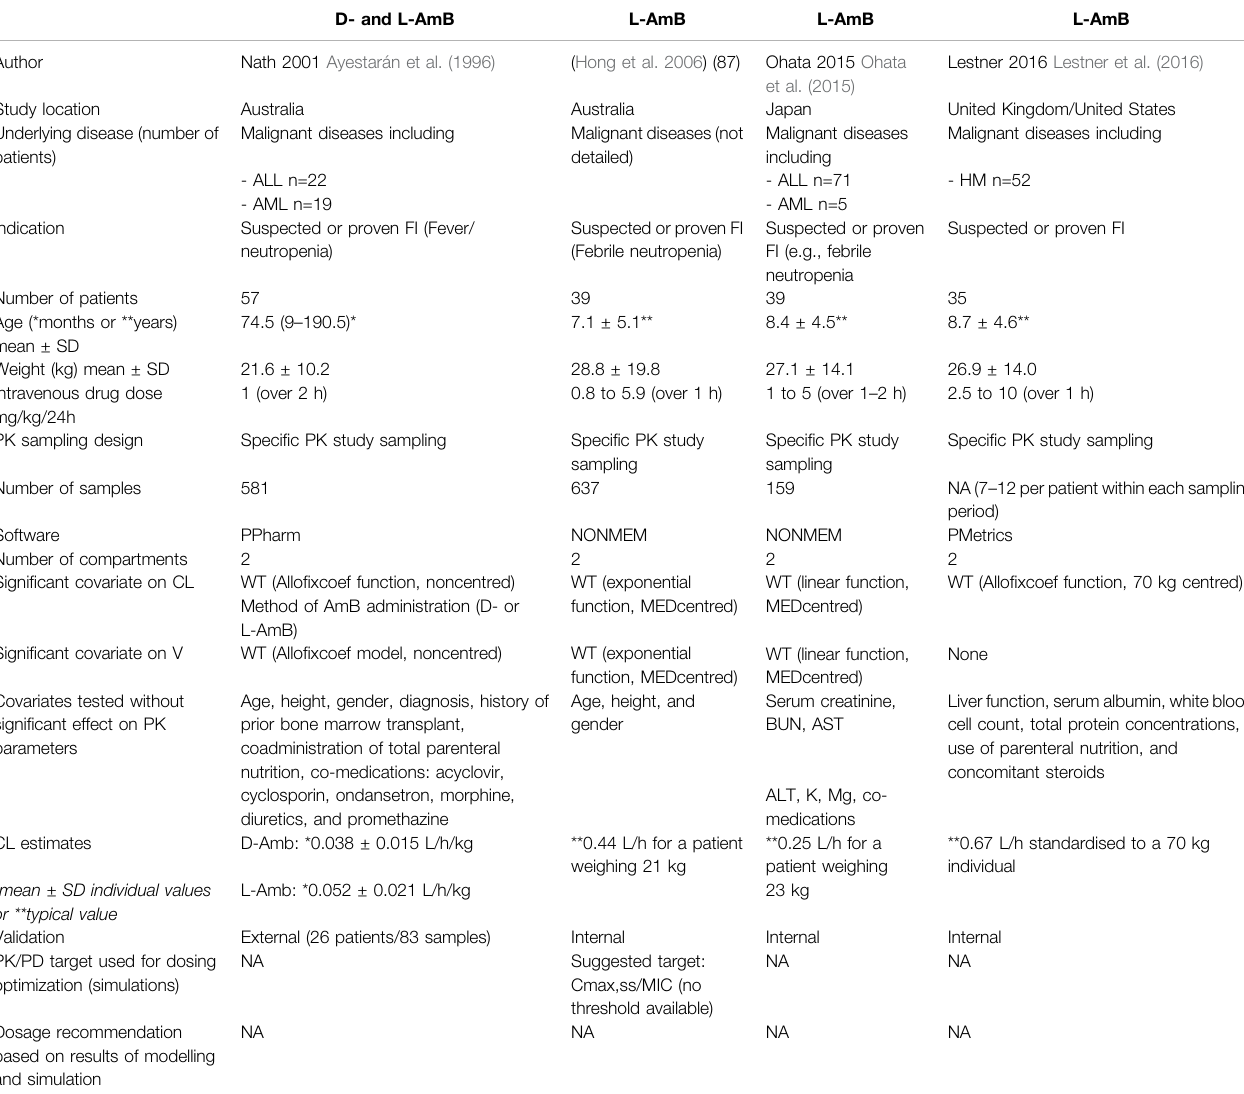
TABLE 4 | Population pharmacokinetic studies of dextrose and lipid Amphotericin B (D and L-AmB) in paediatric onco-hematological